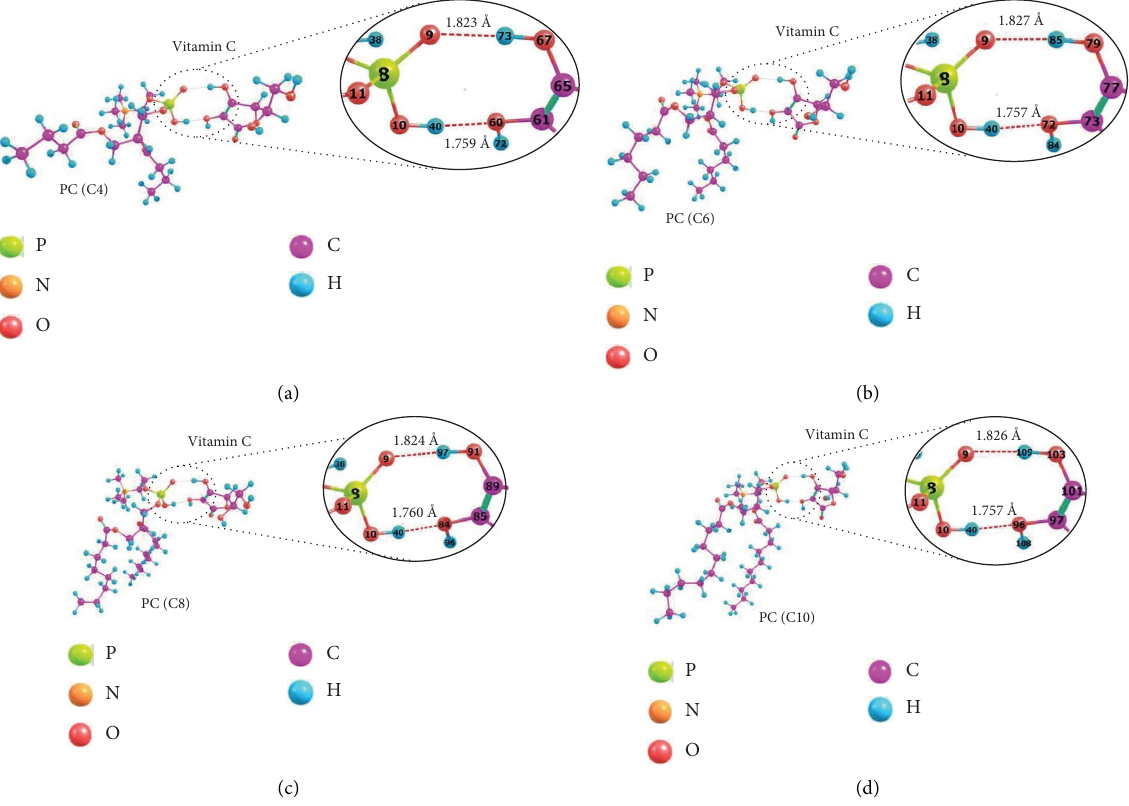
Figure 6: Te interaction of phospholipid and vitamin C molecules using an optimized structure, as follows: (a) PC(C4) ·· · VitC,